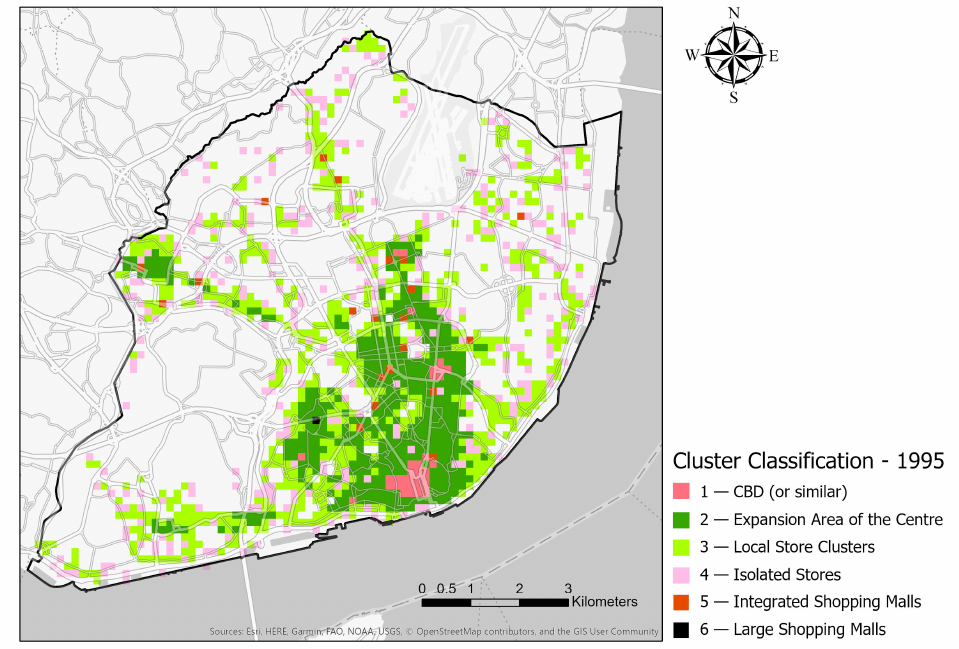
Figure 2. Cluster Figure 2. Cluster Classification—1995.